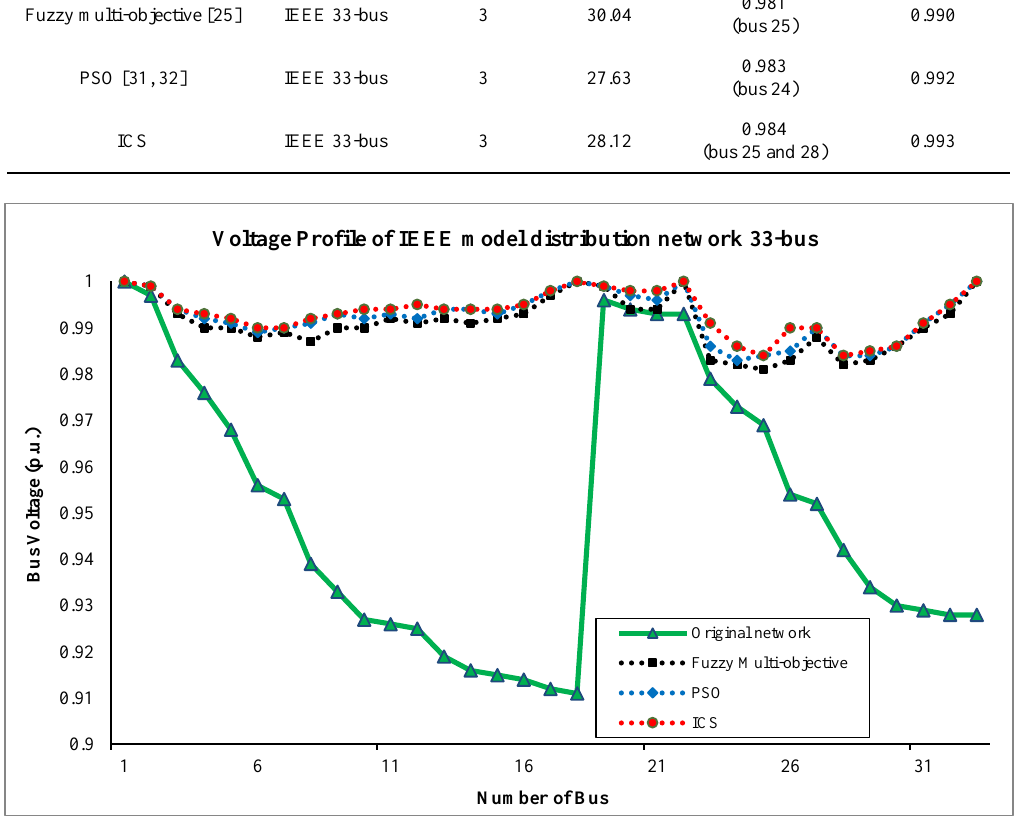
Figure 9. Comparison of voltage profile of the proposed ICS method with fuzzy multi-objective and PSO